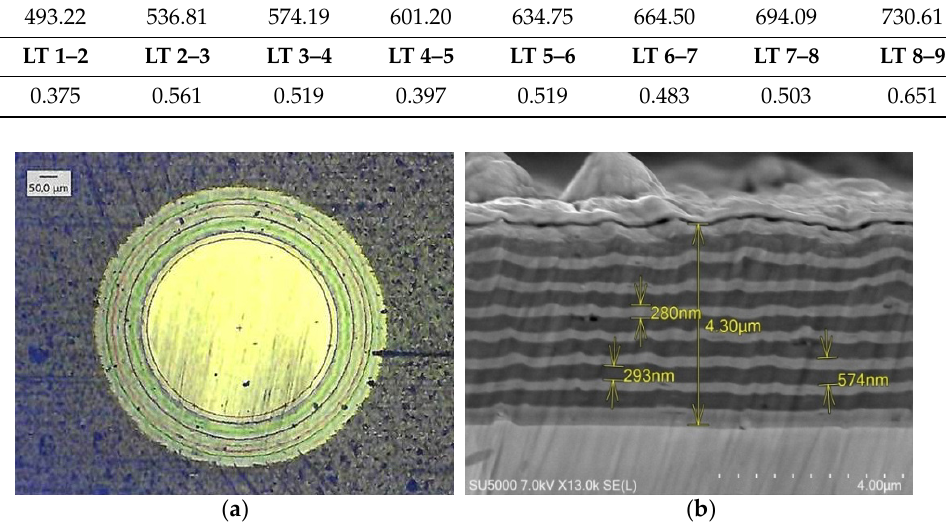
Figure 4. Coating and period thickness as measured by: ( a ) calotester and ( b ) SEM cross-section image of the as-deposited CrAlSiN-AlSiN coating. Table 2. Protocol of the period and total coating thickness measurement by calotest.